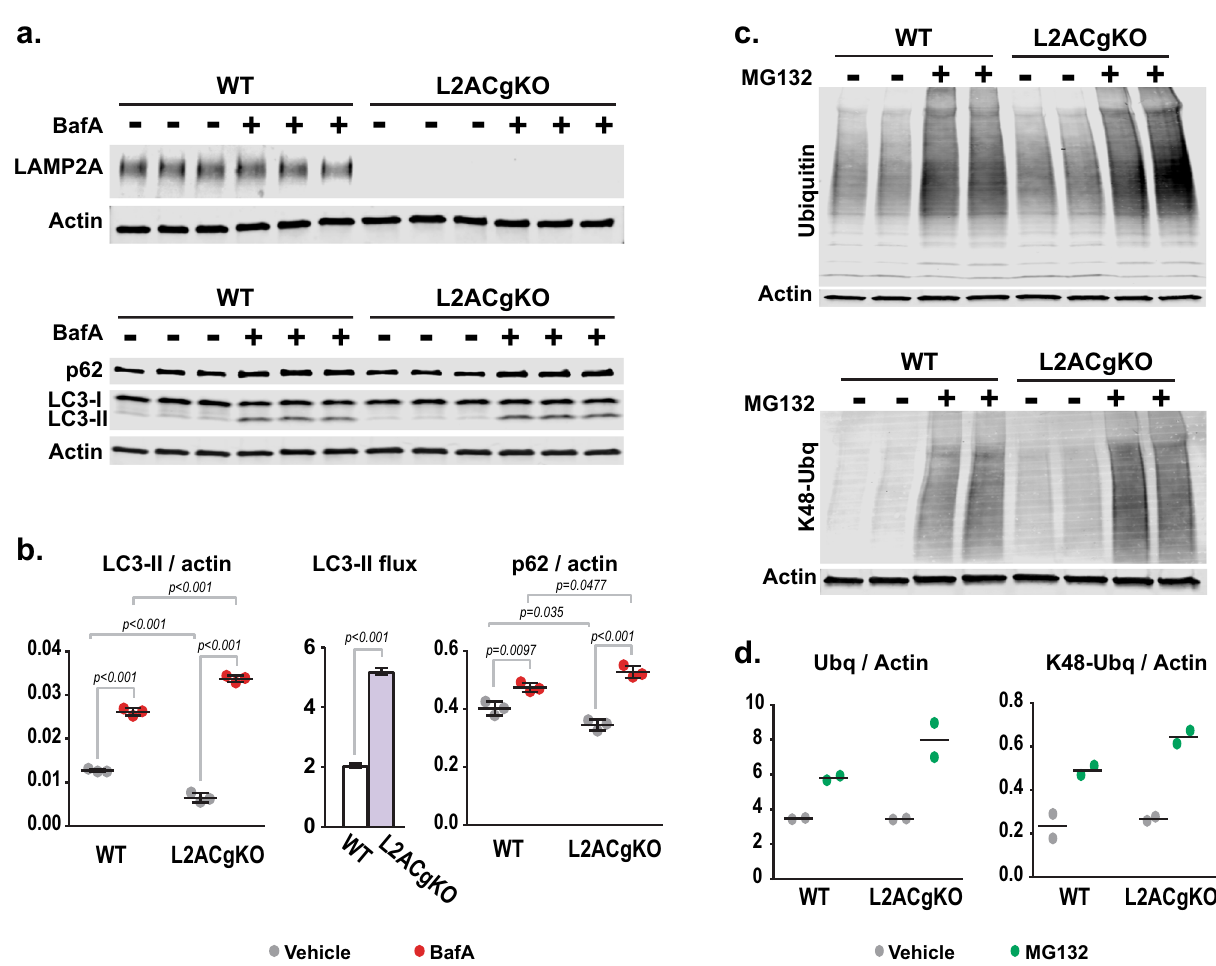
Figure 7. Macroautophagy and proteasomal degradation increase in the absence of CMA. Calvarial osteoblasts were isolated from Lamp2AC global knock-out (L2ACgKO) mice and their control littermates (wild-type mice, WT). ( a ) Calvarial osteoblasts isolated from one mouse per genotype were plated in 6 well plates and cultured with vehicle (DMSO) or 100 μM Bafilomycin A (BafA) for 4 h. LAMP2A, LC3, and p62 protein levels were determined by western blot analysis. ( b ) LC3-II and p62 levels were quantified and normalized to actin levels. For LC3-II flux analysis BafA treatment of each genotype was normalized its vehicle treatment. n = 3 wells/ treatment per genotype. Lines indicate mean ± STDEV. For comparisons of LC3-II/actin and p62/bactin levels p values were calculated and evaluated by Two-way ANOVA. For LC3-II flux comparison p value was calculated and evaluated by student’s t -test; *, p < 0.05. This experiment was repeated using calvarial cells isolated from another set of WT and L2ACgKO mice. These results can be found in S. Fig. 7c. (c,d ) Calvarial osteoblasts isolated from one mouse per genotype were plated in 6 well plates and cultured with vehicle (DMSO) or 50 μM of proteasome inhibitor MG132 for 6 h. The levels of ubiquitinated proteins and K48-linked ubiquitinated proteins were quantified by Western blot analysis. Full-length blots can be found in S. Fig.